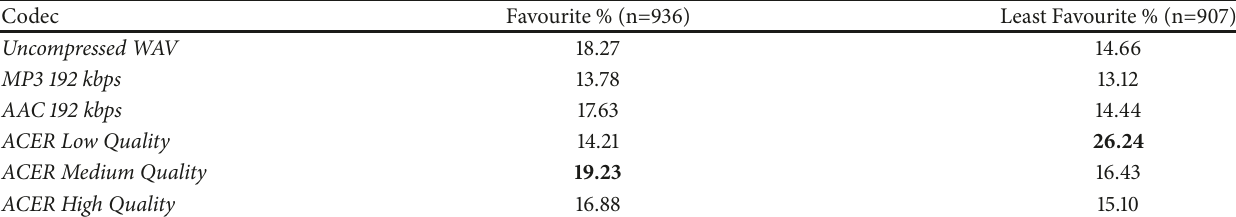
Table 8: Favourite and least favourite codec across all songs (largest values are highlighted in